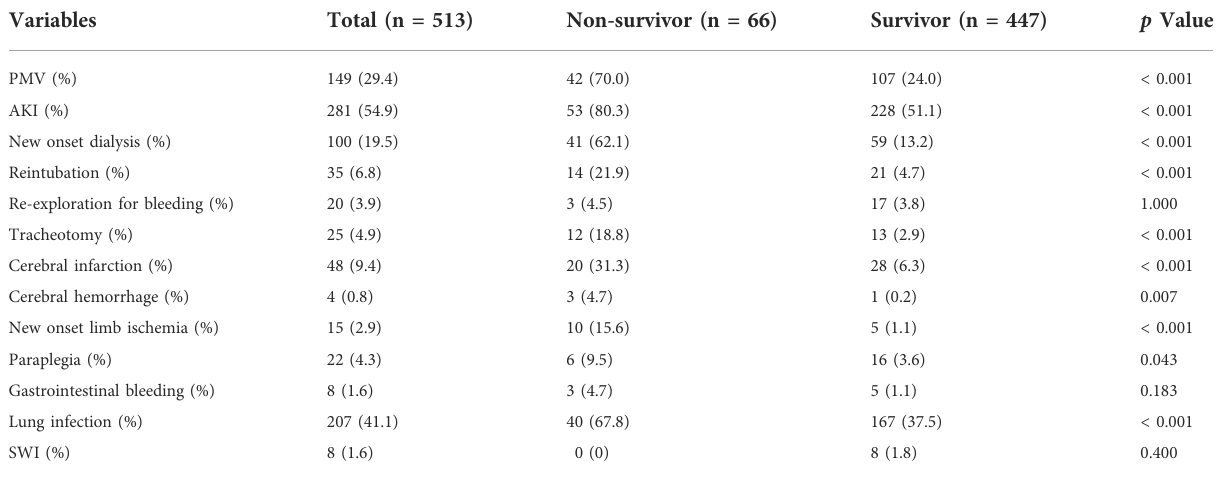
TABLE 3 Comparison of postoperative